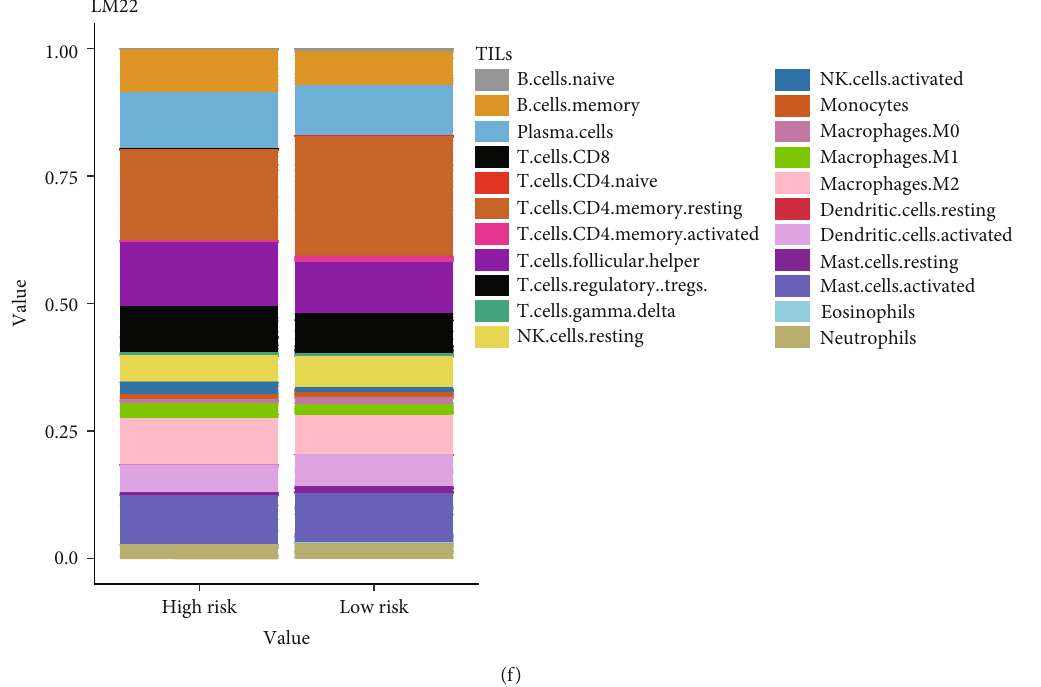
Figure 3: Construction of the 8 gene-based signature. (a) Cross-validation for tuning parameter selection in the Lasso Cox model. (b) Individual coe ffi cient of each of the 8 markers. (c, d) GSEA analysis according to “ hallmark gene sets. ” The complement, E2F targets, G2M checkpoint, and unfolded protein response pathways were activated in the high-risk group ( p < 0 : 05 ). (e, f) CIBERSORT showed no di ff erence in immune cell fractions in the low-risk and high-risk